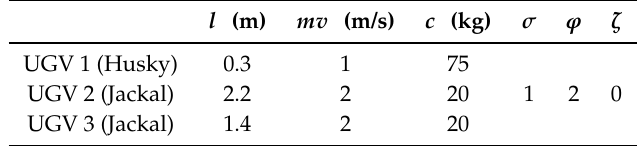
Figure 8. Experiment conducted in a real-world environment. Three heterogeneous robots (two Jackal robots and one Husky robot) were used in the experiment. Table 3. Specifications of heterogeneous robots and gain coefficients used in the experiment.